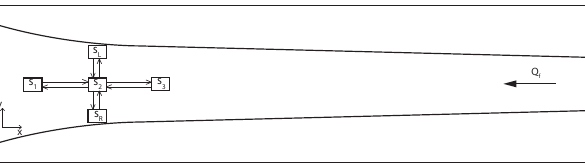
Figure 2. Conceptual sketch for lateral and longitudinal mixing. Longitudinal and lateral mixing lengths are (cid:49)x and (cid:49)y , respec-